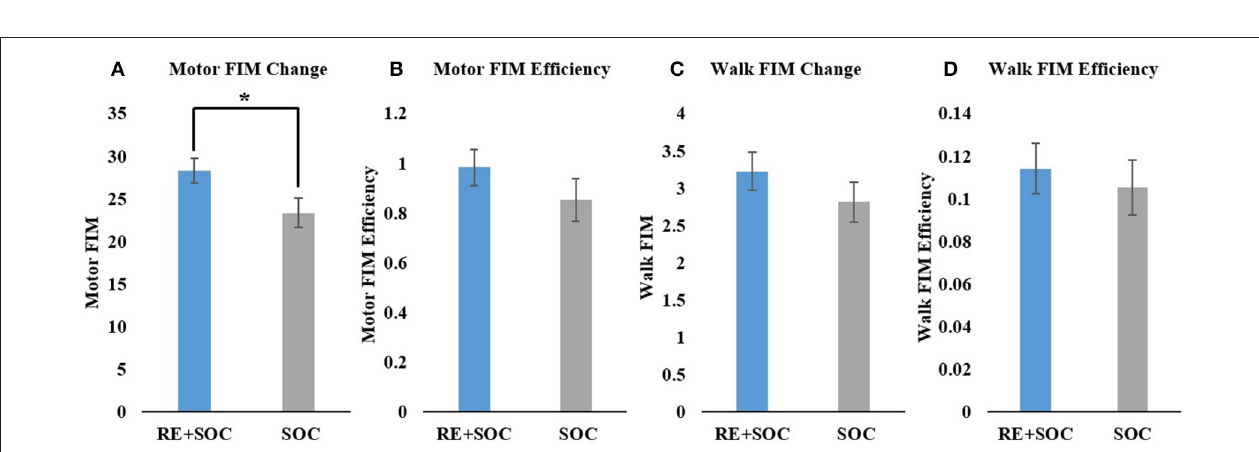
FIGURE 2 | (A) The total distance walked during inpatient rehabilitation for the RE + SOC (includes sessions with the RE and during standard of care physical therapy) and SOC group (includes sessions during standard of care physical therapy); (B) The total distance walked during conventional physical therapy (standard of care physical therapy, excludes any sessions with the RE) during inpatient rehabilitation for the RE + SOC and SOC groups; (C) The average distance walked during each physical therapy session; and (D) The maximum distance walked during conventional physical therapy for the LOS. In case of the RE + SOC group, the average maximum distance was determined as the maximum distance after the first RE training. All data are presented as mean ± standard error. *Significance of p < 0.05.